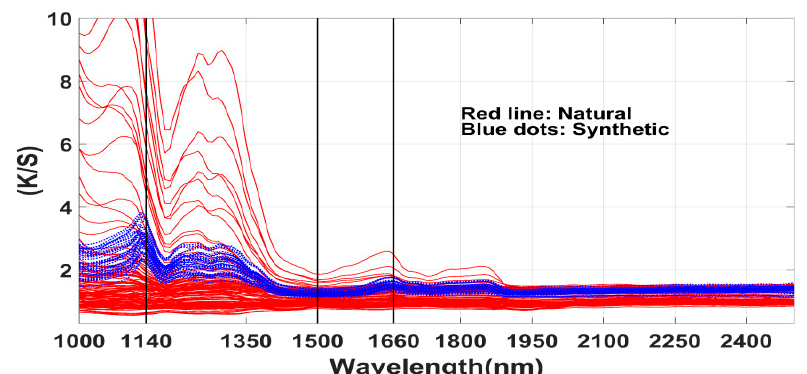
Figure 8. Reflectance spectra transformed to ratio of absorption and scattering coefficients (K/S) and the locations of selected bands (1140 nm, 1500 nm, 1660 nm) indicated by vertical lines.